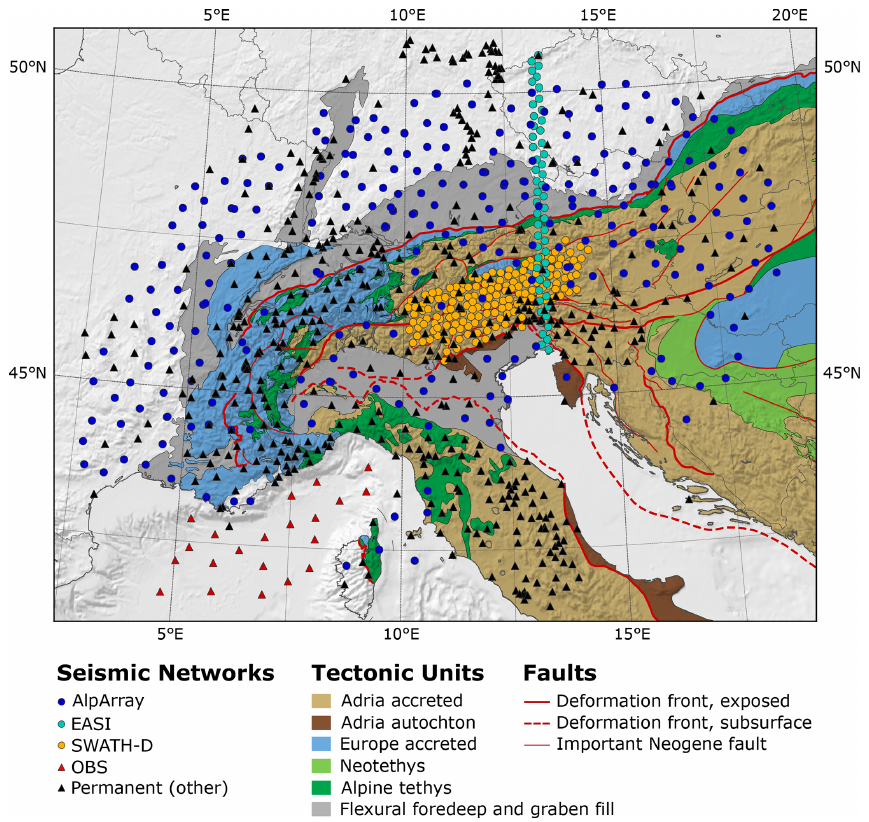
Figure 1. Tectonic map of the Alpine chains compiled by M. R. Handy showing different seismic networks as well as temporary experiments, tectonic units and major fault